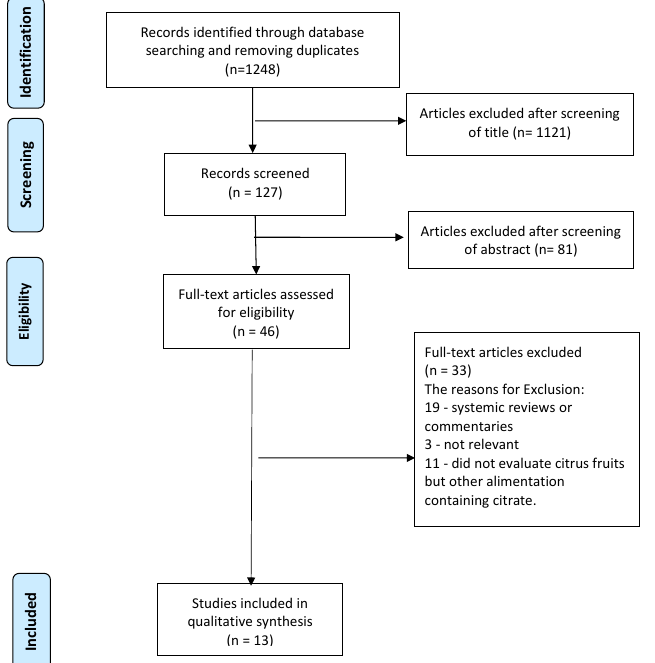
Figure 1. PRISMA flowchart of the included studies—please see revised PRISMA chart in a separate file